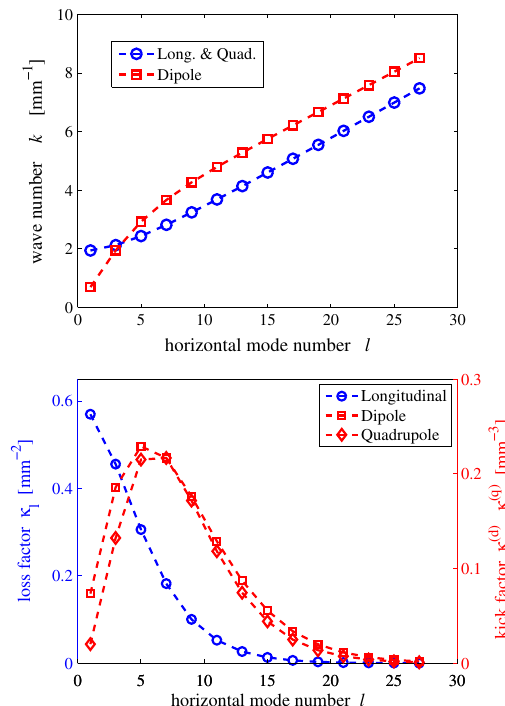
FIG. 4. Wake of the dechirper (see Table I with a ¼ 0 . 7 mm), as calculated using the field matching program (solid lines): (up) the longitudinal, W jj , (down) the dipole W (blue) and quadru- d pole W (red) wake functions. The wakes according to the q analytical model are also shown, for comparison (dashed lines). The fitting formula for the longitudinal wake is also shown for comparison (red